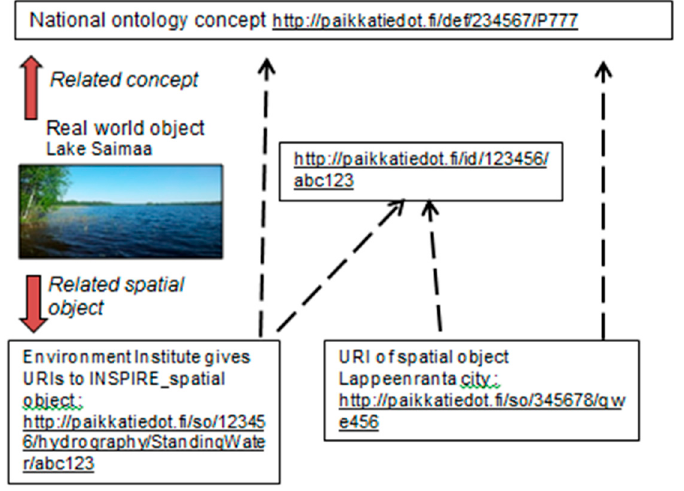
Figure 4. Implementation of URI references for real-world entities in the new national geospatial platform in Finland, according to National recommendation for unique identifiers of spatial data.